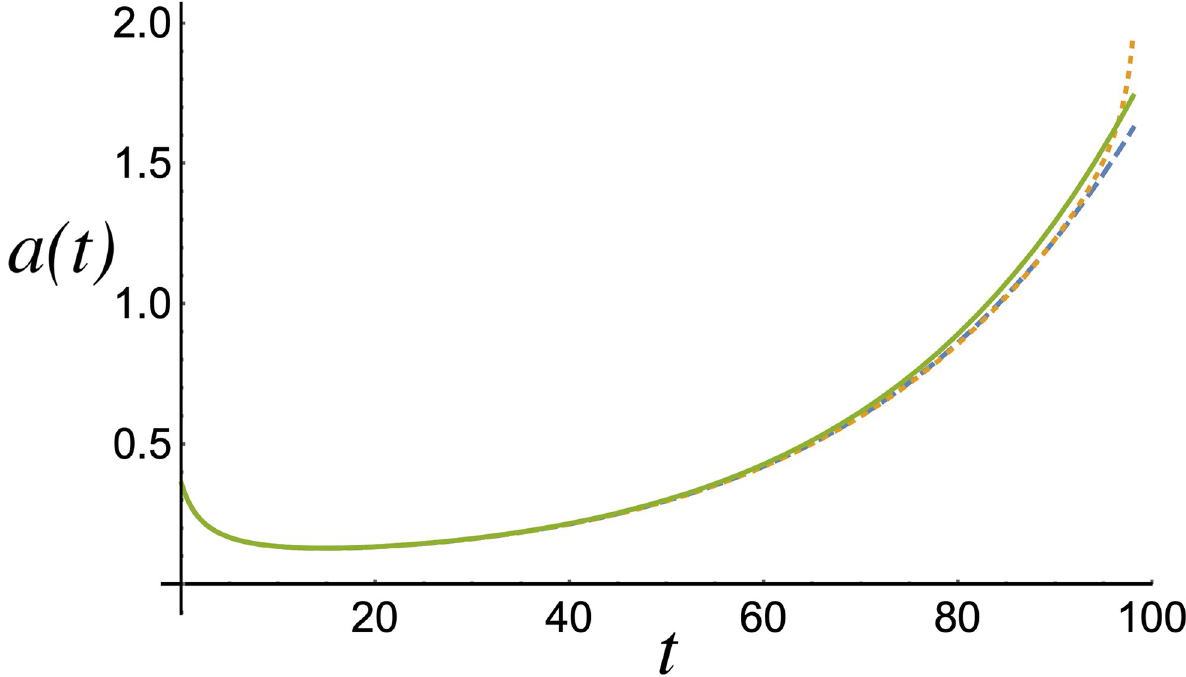
Fig 4. Amplitude of W ( x , t ), i.e., a ( t ) = 1/ A ( t ) as a function of time. In each case, the amplitude increases as time progresses. The dotted, dashed, and solid lines represent the amplitudes associated with c 1 ( x ), c 2 ( x ), and c 3 ( x ), respectively, for h 2 > 0.